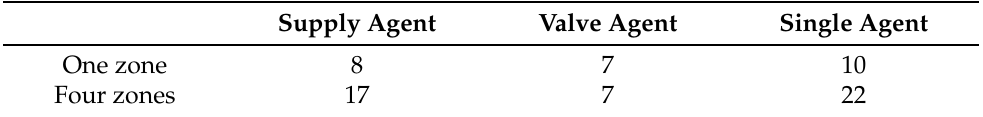
Table 4. Overview of how the number of input states is increasing when more zones are added to the system for both MARL and SARL.